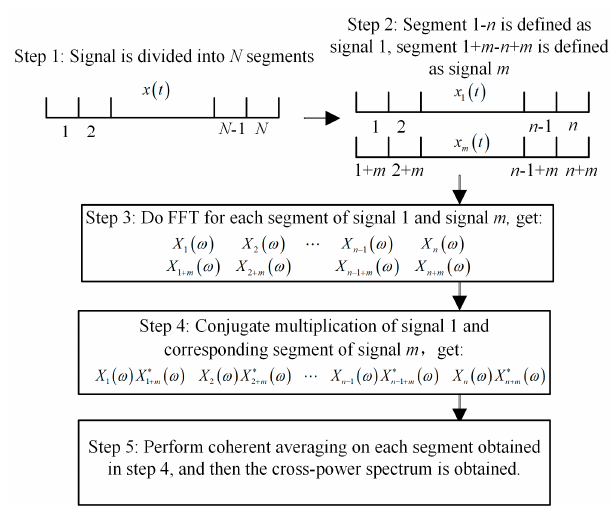
Figure 1. Schematic diagram of SHCS method.